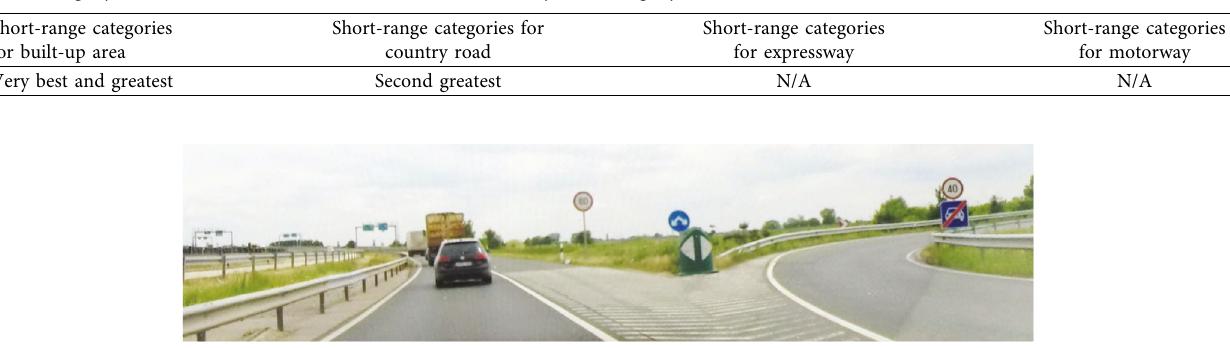
Figure 3: A directly road-type-related TS—namely, the “end of expressway” TS appearing in the right-hand side of the photo—that does not apply for the ego car moving in the left lane.